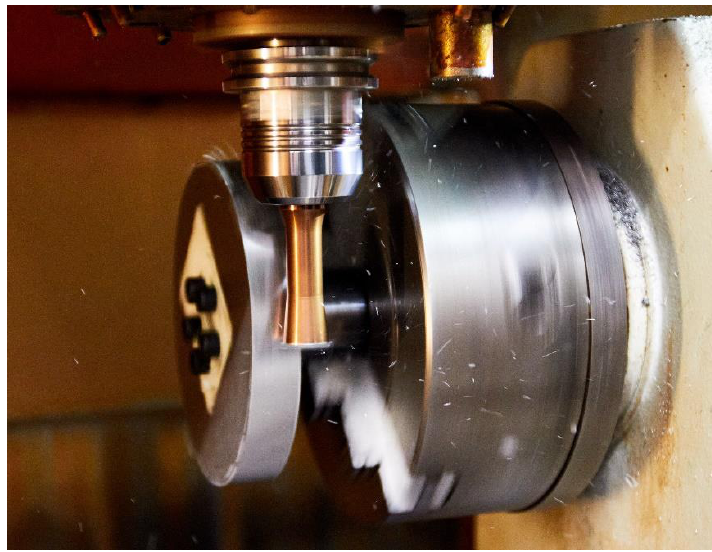
Figure 4. Setup scheme of the experimental environment.